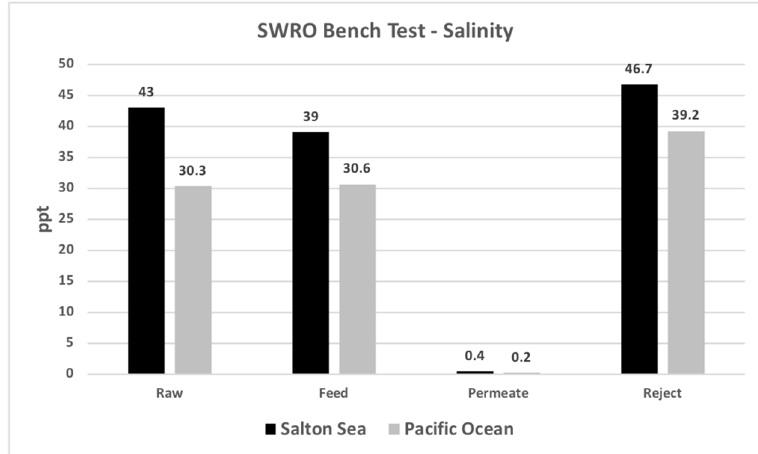
Figure 8. Salinity of raw water, SWRO feed, permeate, and reject flow.